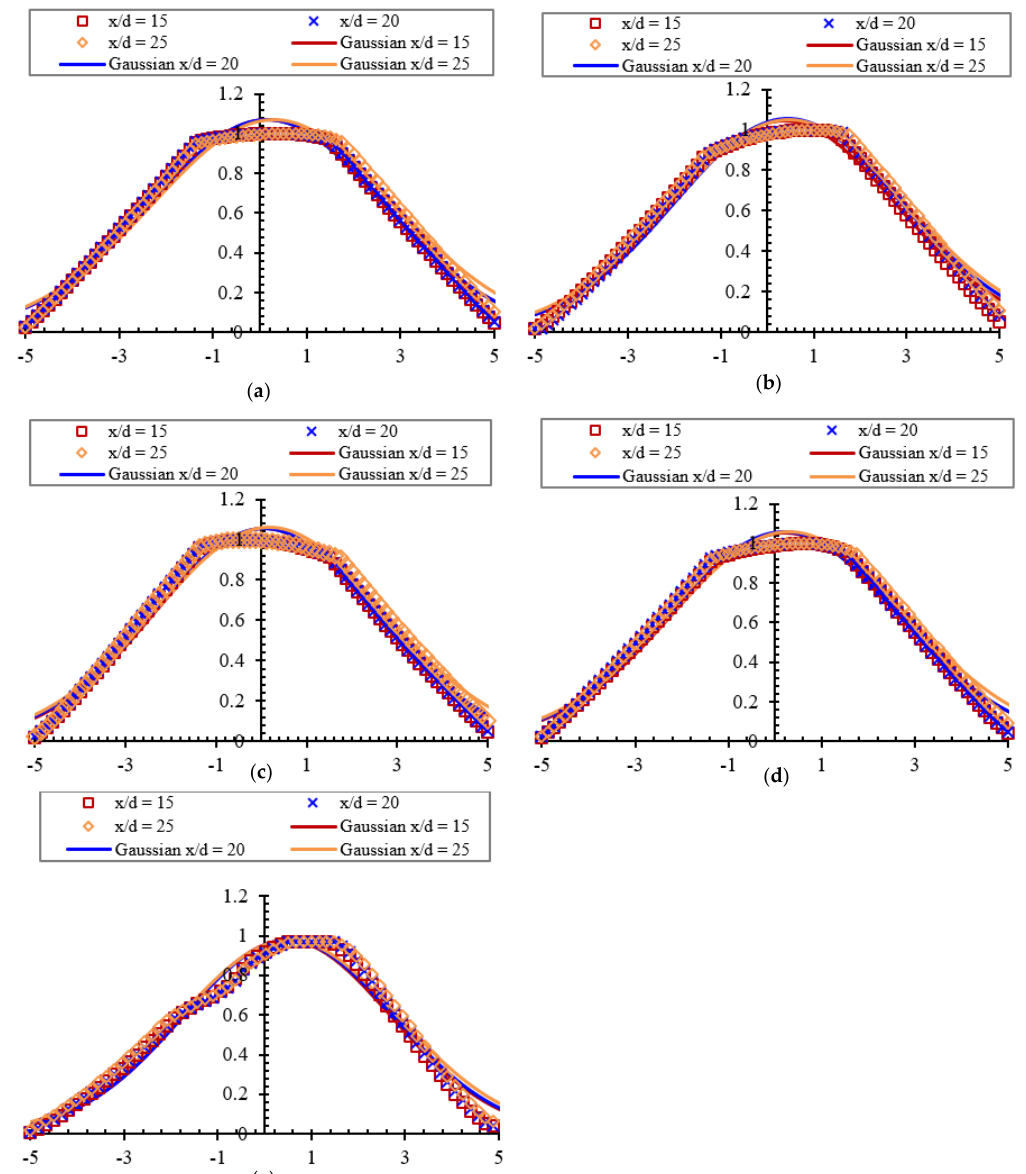
Figure 5. Radial velocity at various axial distances for different nozzle velocity: ( a ) 0.18 m/s, ( b ) 0.32 m/s, ( c ) 0.45 m/s, ( d ) 0.62 m/s, and ( e ) 1.16